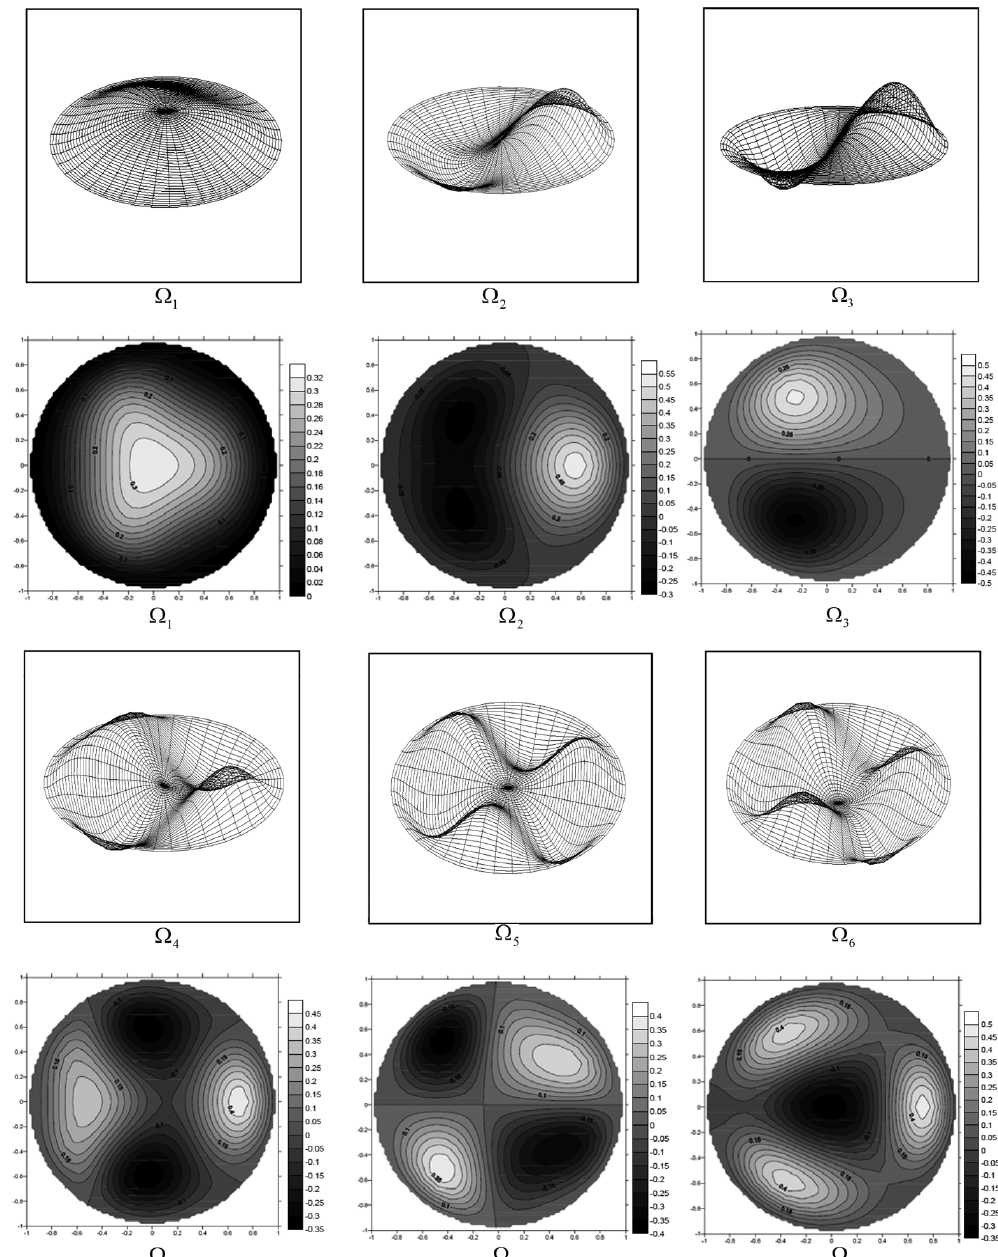
Fig. 7. First six normal modes and their contours for C-plates when α = β = 0.5 and k =